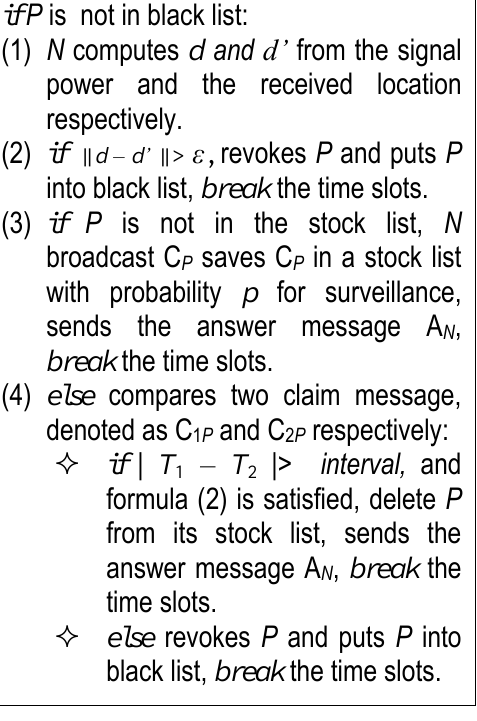
Figure 3. Detection algorithm of patroller